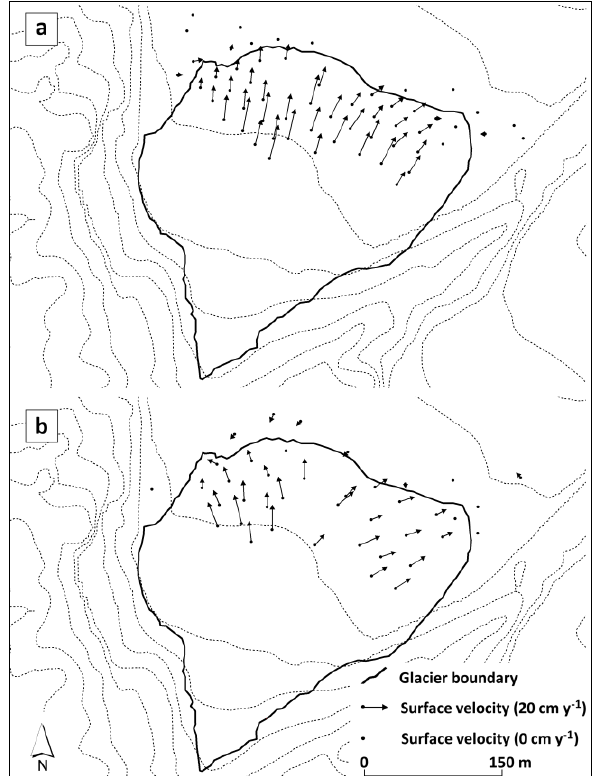
Figure 6. Annual surface velocities from September 2010 to September 2011 (a) and from September 2011 to October 2012